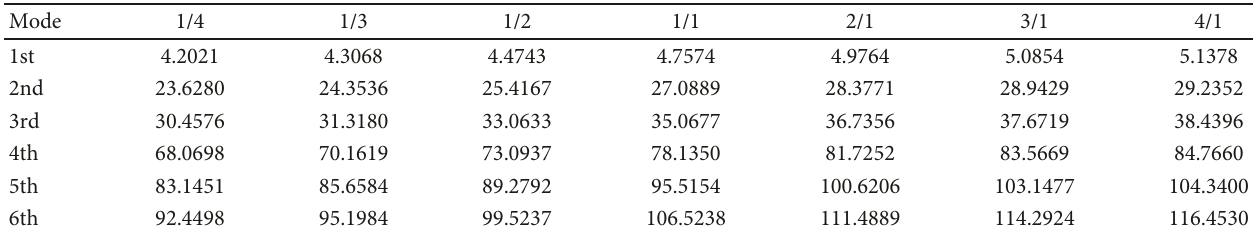
Table 9: Nondimensional frequency parameters for the fi rst six modes of the FG sandwich blade with varying layer thickness ratios ( l = 3 , h = 20 , n = 2 , and θ = 30 ° ).